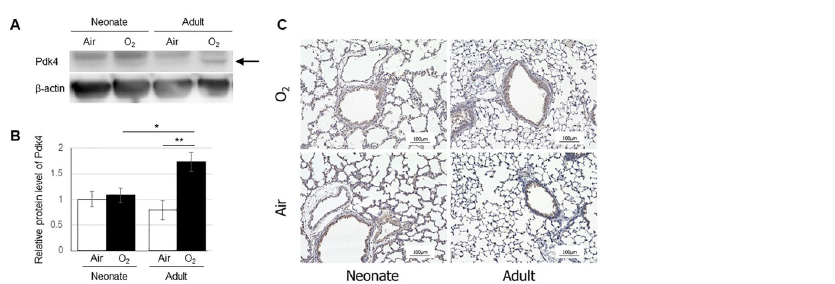
Fig 6. Expression levels of Pdk4 protein in the lungs quantified by Western blot (A,B) and immunohistochemical localization of Pdk4 protein in the lung (C). (A) The arrow indicates a band of Pdk4 protein. (B) The vertical axis shows the relative expression of Pdk4 protein. Data are shown as means ± SEM. Comparisons between groups were performed using a t test. � p < 0.05; �� p < 0.01. Air: normoxia; O2: hyperoxia; SEM: Standard error of the mean. (C) Immunostaining was observed in the epithelium of terminal bronchiole in all four groups (brown). Scale bar = 100 μ m.